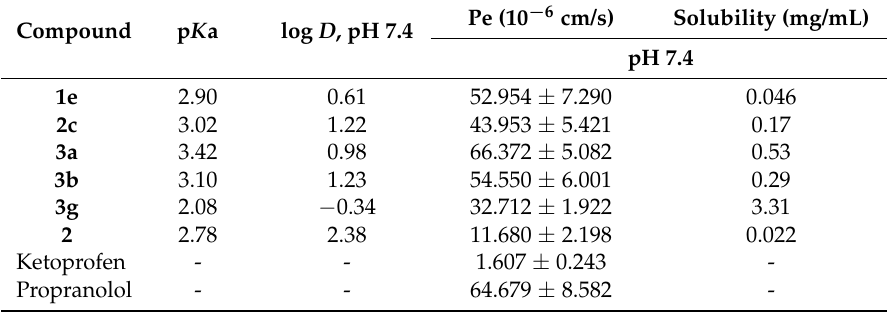
Table 2. Physicochemical properties of selected